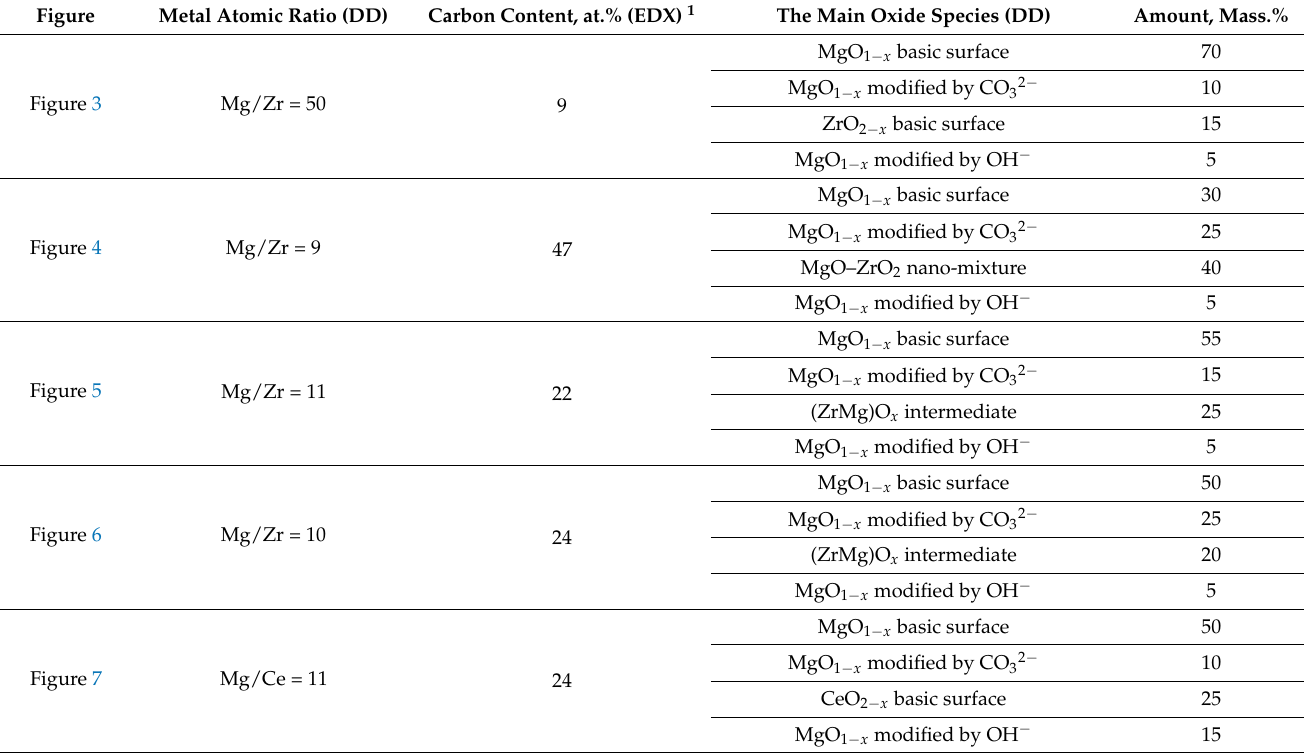
Figure 7. The mixed oxide film with n(Mg):n(Ce) = 11 according to DD data: SEM images ( a , b ), XRD pattern ( c ) DD curves ( d ), SEEC (Ep) curves ( e ). Table 2. The chemical characterization of the mixed oxide films deposited by MOCVD from a combination